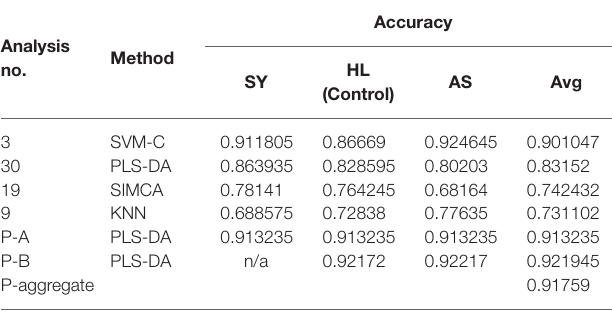
TABLE 4 | Performance of the best classification model of each type on the Rose